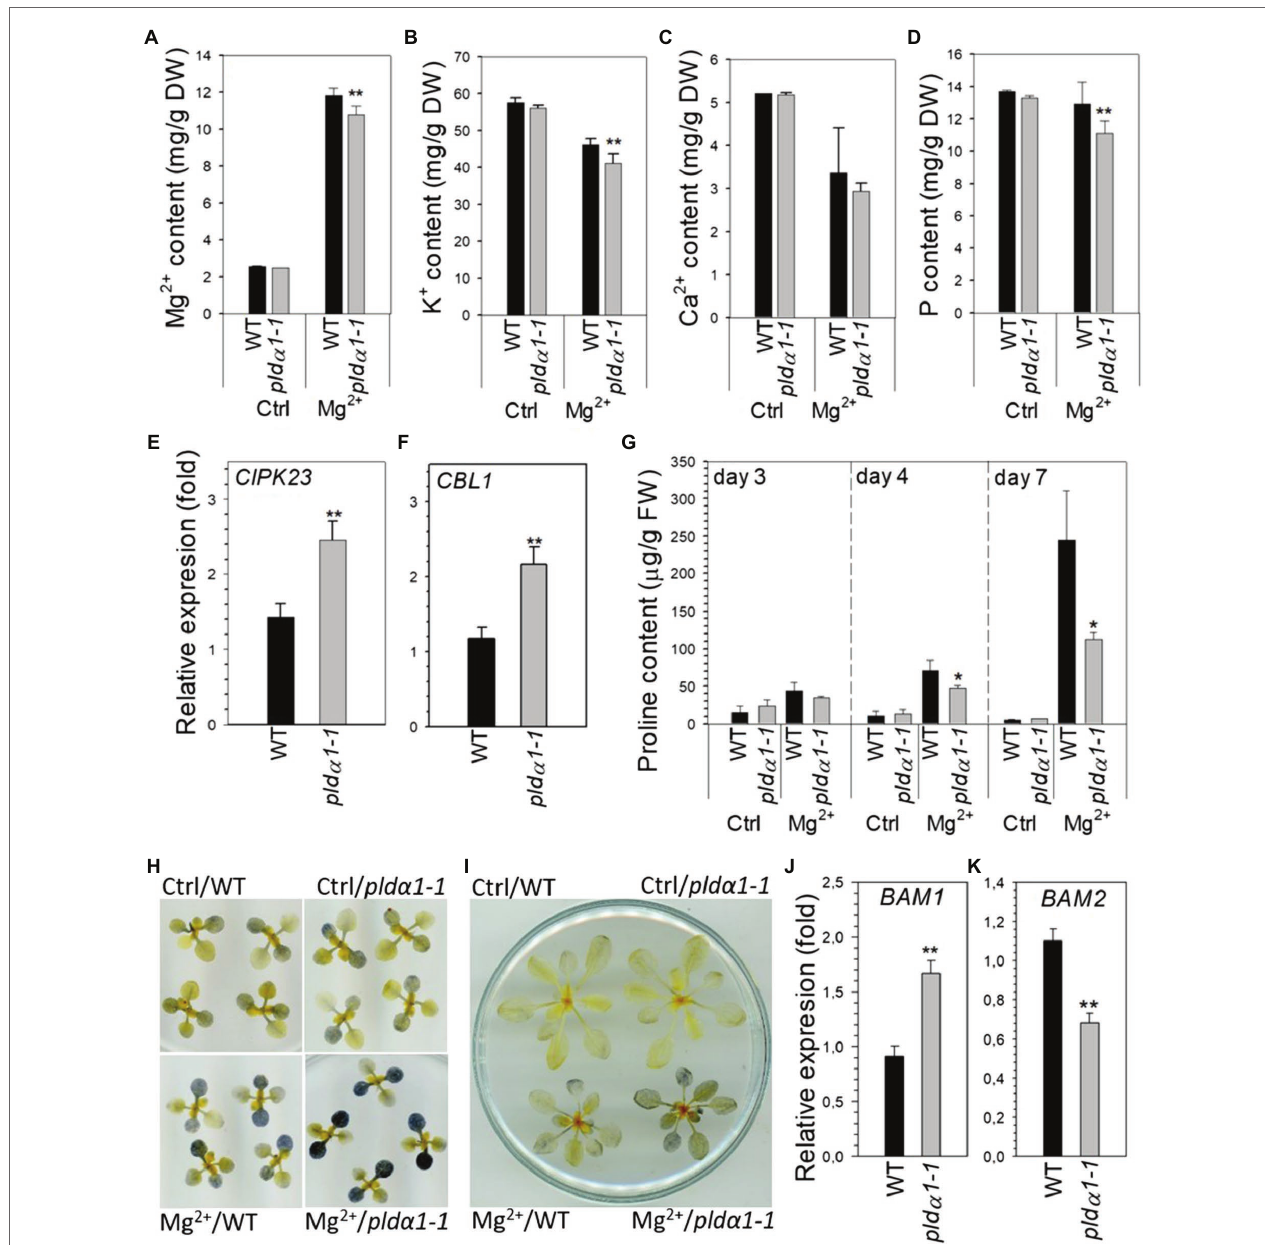
FIGURE 4 | Nutrient, proline and starch content is altered in pld α 1-1 in high-Mg 2+ conditions. (A–D) Magnesium (Mg 2+ ), potassium, calcium, and phosphorus content in rosettes of WT and pld α 1-1 plants. Bars represents means ± SD, n = 3 for control, n = 8 for Mg treatment. (E,F) Transcript level of CIPK23 and CBL1 in rosettes. Transcription was normalized to a reference gene SAND and the transcription of non-treated plants was set to one. Values represent means ± SE, n = 12, (A–F) 10-day-old Arabidopsis seedlings were transferred on agar plates containing 15 mM MgSO 4 for 7 days. (G) Proline content, 24-day-old hydroponically grown plants were treated with 15 mM MgSO 4 . Proline content was measured in leaves 3–6. (H) Lugol staining of starch in rosettes from control and high Mg 2+ condition at the end of dark period. Ten-day-old Arabidopsis seedlings were transferred on agar plates containing 15 mM MgSO 4 for 3 days. (I) Lugol staining of starch in rosettes from control and high Mg 2+ condition at the end of dark period, 24-day-old hydroponically grown plants were treated with 15 mM MgSO 4 for 3 days. (J,K) Transcript level of BAM1 and BAM2 in leaves 3–6, 24-day-old hydroponically grown plants were treated with 15 mM MgSO 4 for 2 days, transcription was normalized to a reference gene SAND and the transcription of non-treated plants was set to one. Values represent means ± SE, n = 12. Student’s t test, asterisk indicate significant difference in comparison with WT * p < 0.05; ** p <